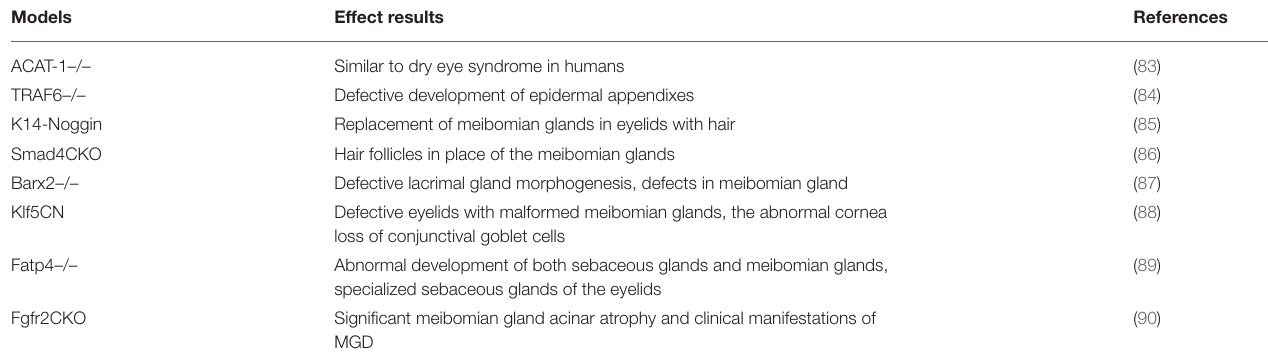
TABLE 2 | Transgenic models of meibomian gland dysfunction.